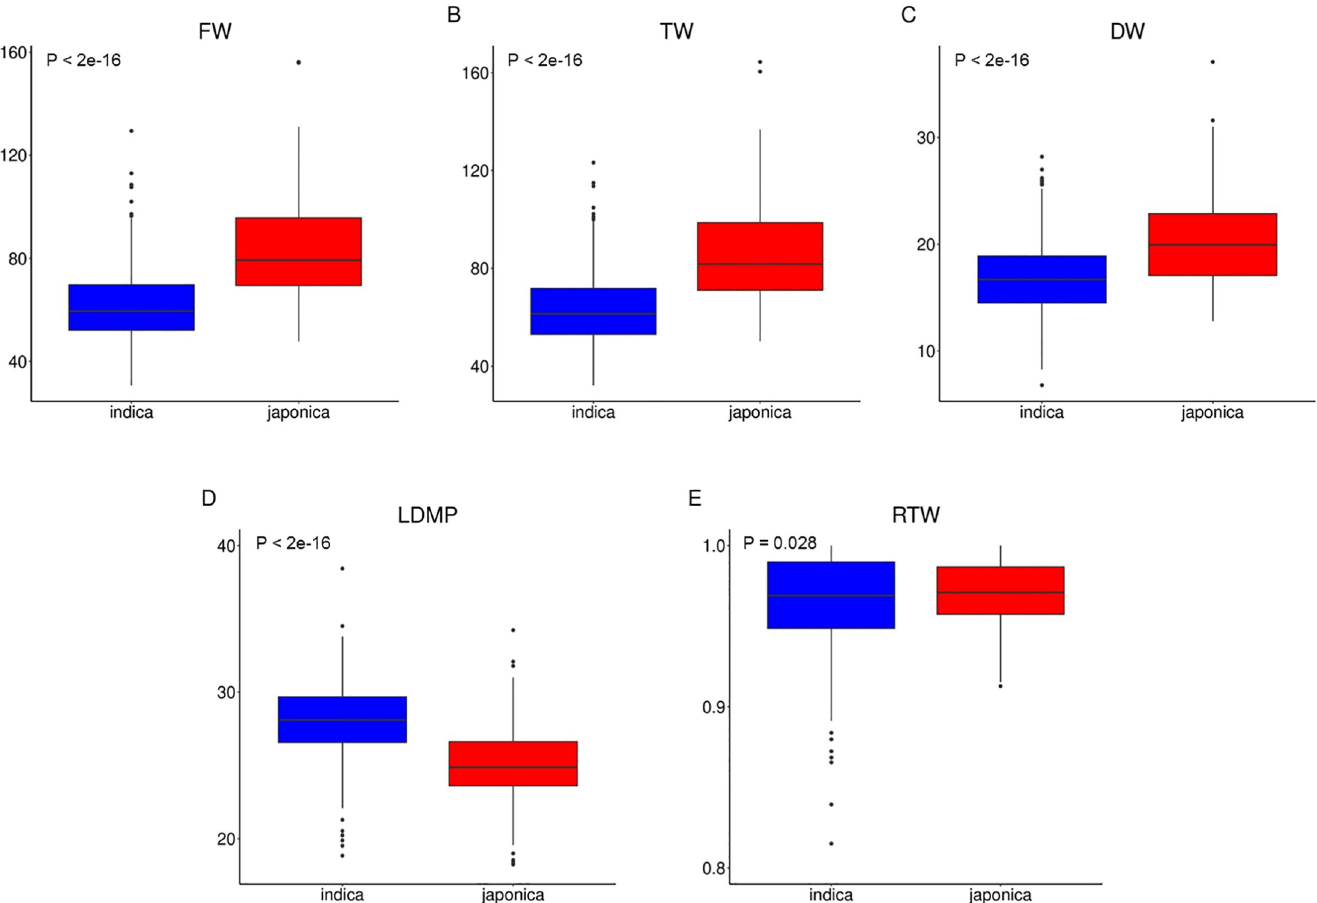
Fig 1. Boxplots of the distribution of leaf mass traits. Indica subpopulation in blue; japonica subpopulation in red; FW: leaf fresh weight; TW: leaf turgid weight; DW: leaf dry weight; RTW: relative tissue weight; LDMP: leaf dry matter percentage. Statistical significance (ANOVA p-values) between the two subpopulations is